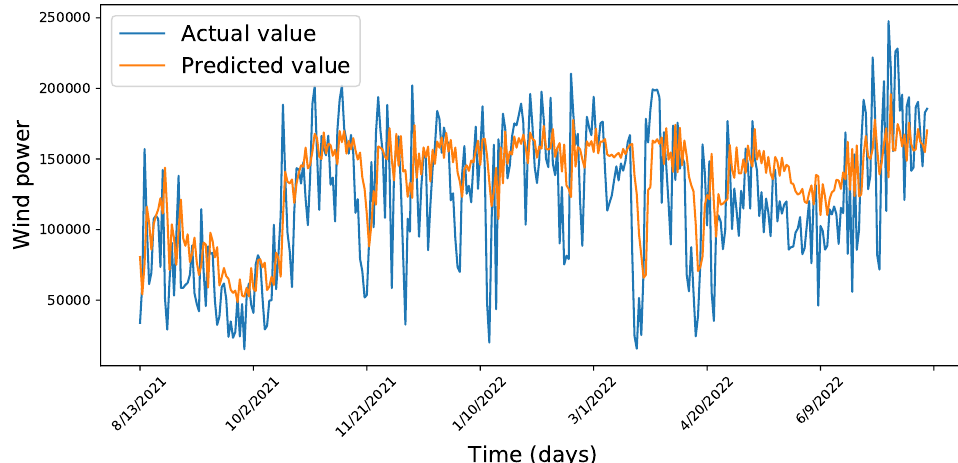
Figure 11. Prediction vs. actual plot for Site